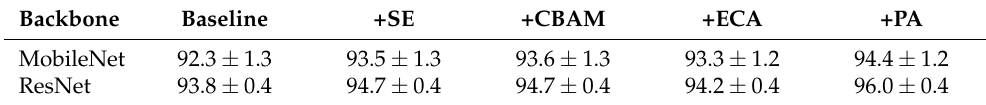
Table 3. Comparison with other attention blocks via MobileNet and ResNet (in %).